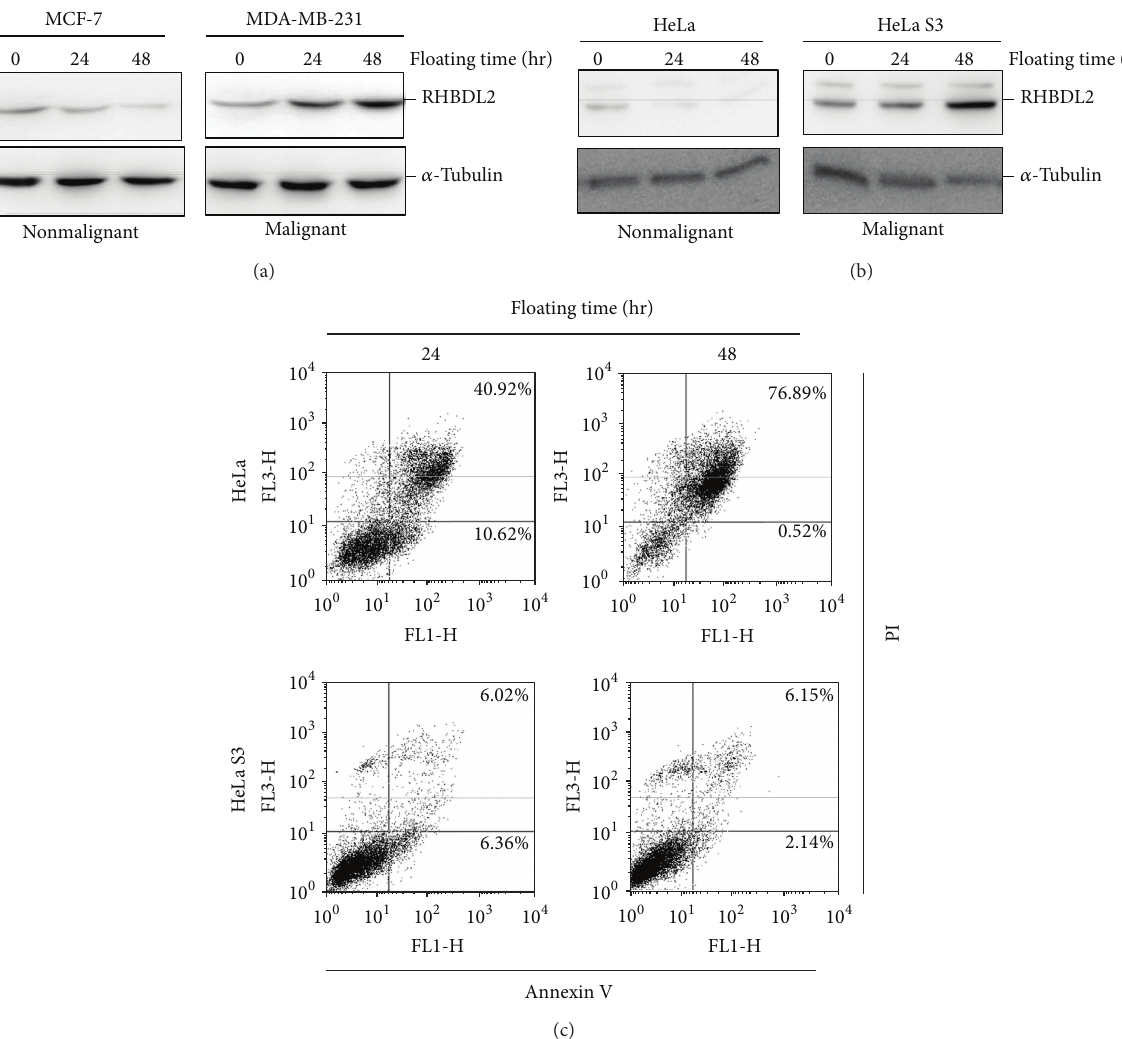
Figure 2: Long-term suspension cultures triggered RHBDL2 upregulation and represent reduced apoptosis in malignant tumor cells. The expression levels of RHBDL2 in suspension-cultured breast (a) and cervical and (b) epithelial tumor cells were detected by Western blot analysis. (c) Detection of apoptotic cells under floating culture condition by using Annexin V-FITC/PI